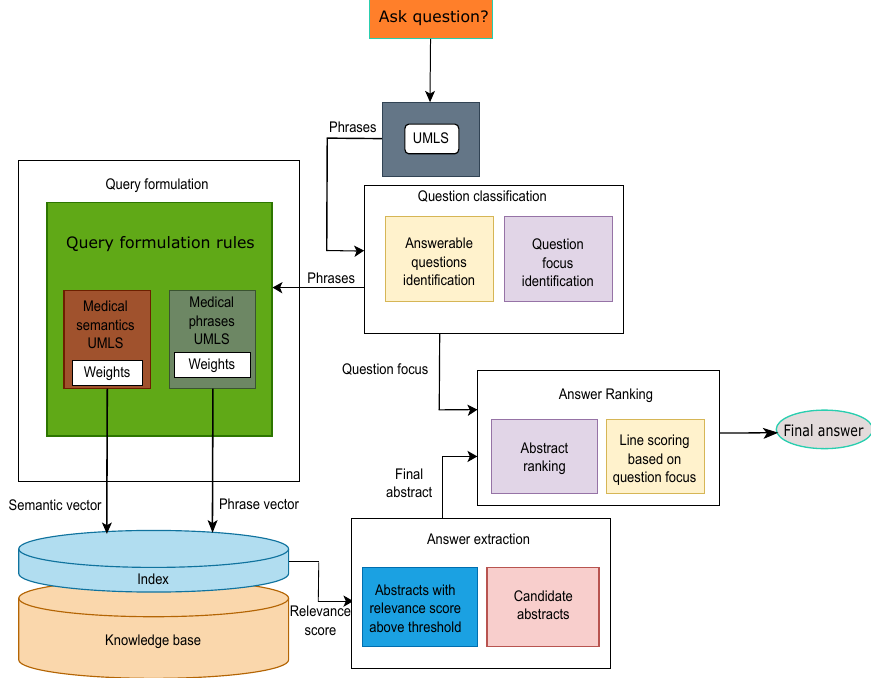
Figure 7. CLINIQA’s system architecture